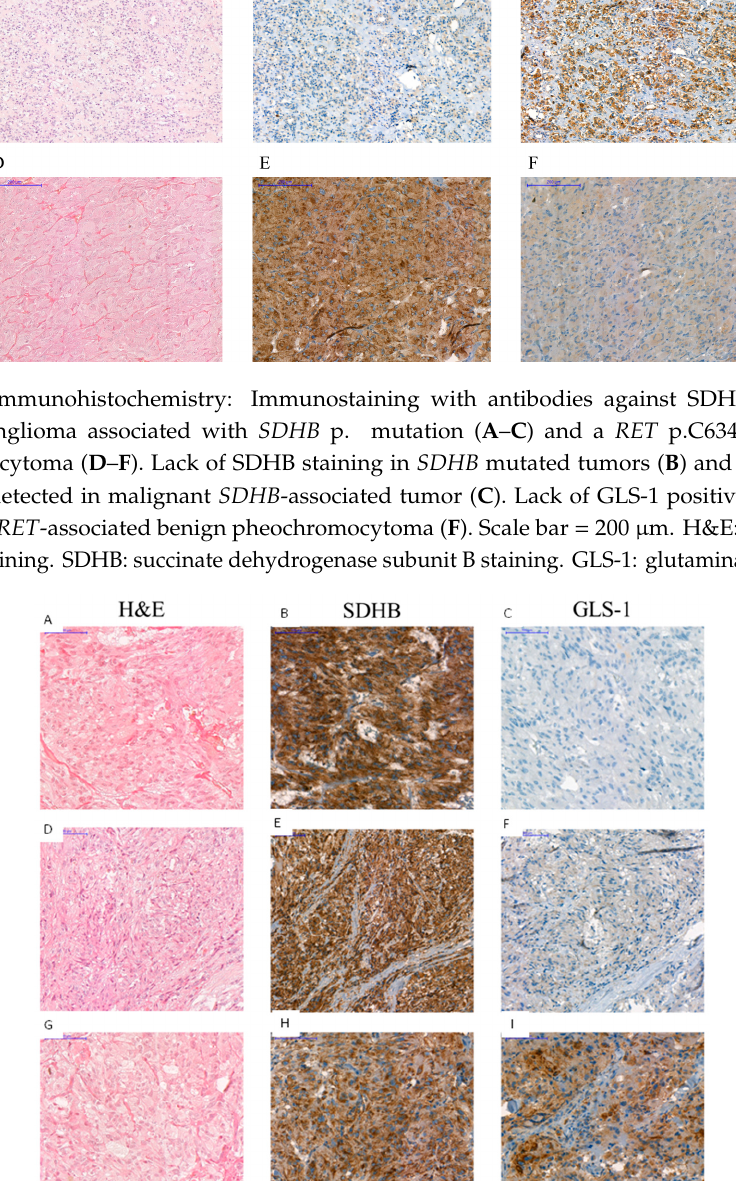
Figure 7. Immunostaining with antibodies against SDHB and GLS-1 of a RET p.C634R-associated pheochromocytoma. Panel A , D , G shows the hematoxylin and eosin stains of the primary tumor ( A ),